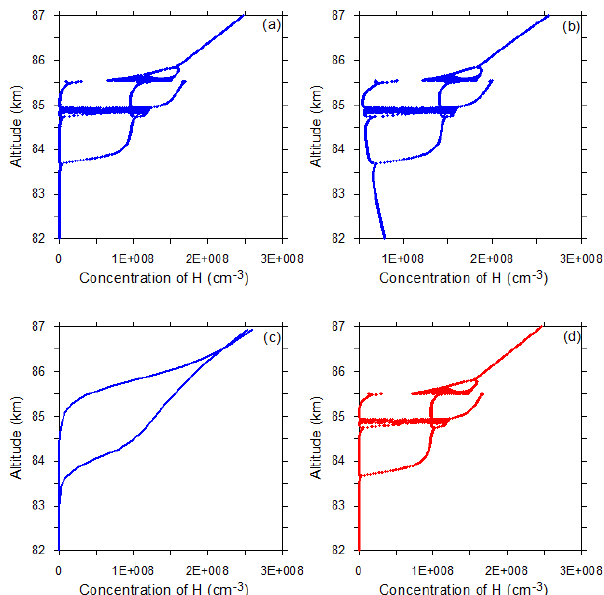
Fig. 1. (a) Bifurcation diagram demonstrating possible modes of MPCS behavior as a function of height; (b) same as in Fig. 1a, but for a different moment of local time; (c) same as in Fig. 1a, but with allowance for vertical eddy diffusion with coefficient 10m 2 s − 1 ; (d) same as in (a) , but without allowance for H+HO 2 → 2OH and O 3 +OH → O 2 +HO 2 reactions.